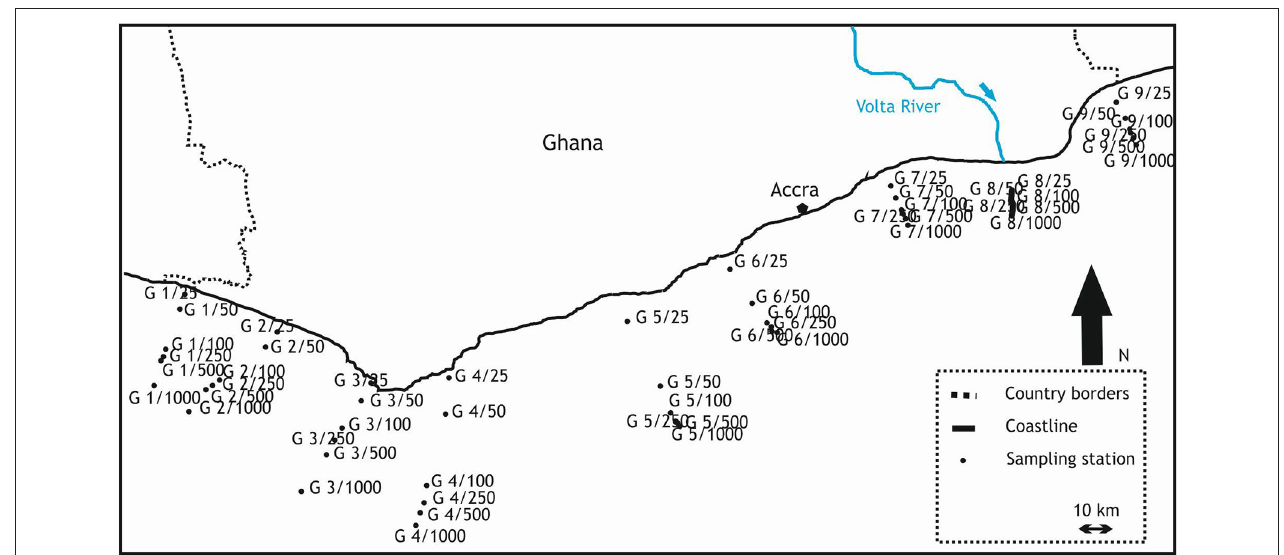
FIGURE 2 | Distribution of sampling stations in the Gulf of